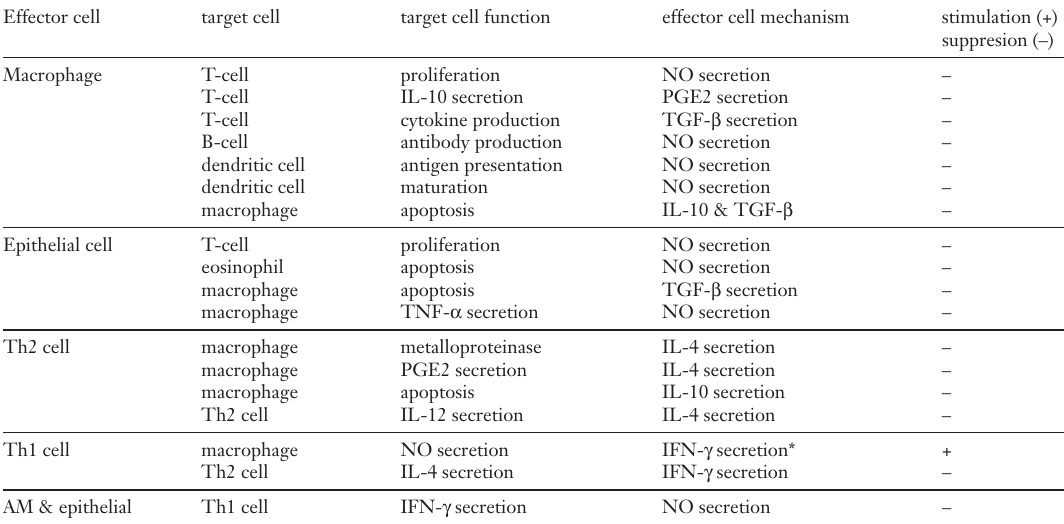
Immunomodulatory cell-cell interactions in the lower respira- tory